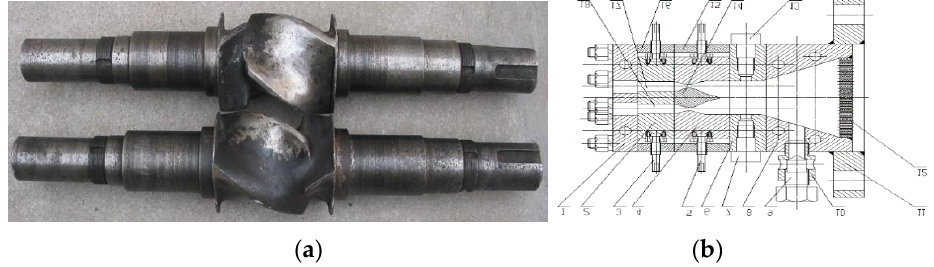
Figure 1. Equipment for short fiber processing and orientation: ( a ) Rotor of tangential types internal mixer for short fiber mixing; ( b ) Structure of dam-expansion die for short fiber radial orientation.